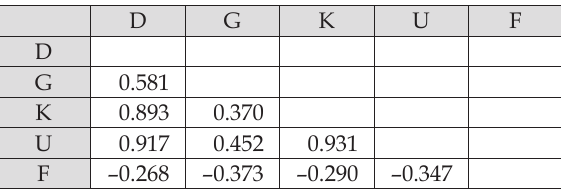
Table 3. Correlation matrix of socio-economic